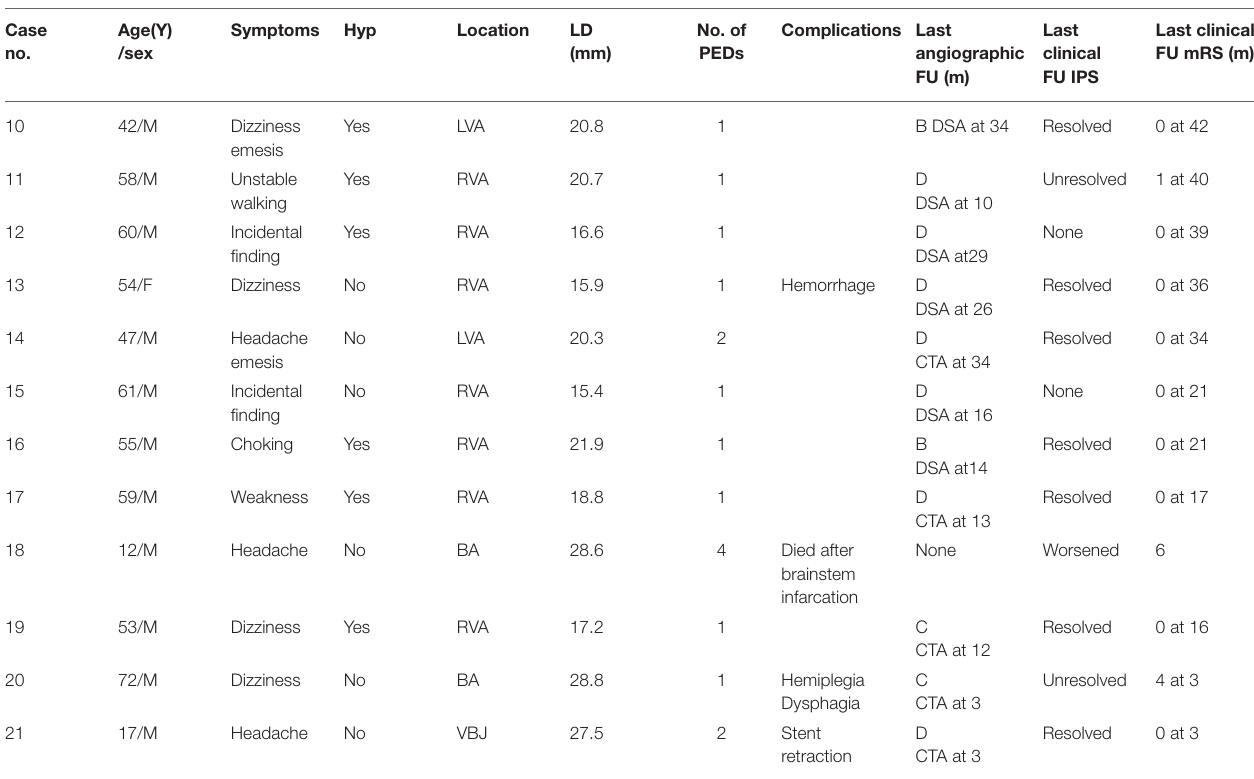
TABLE 2 | Patient data of the PED group.